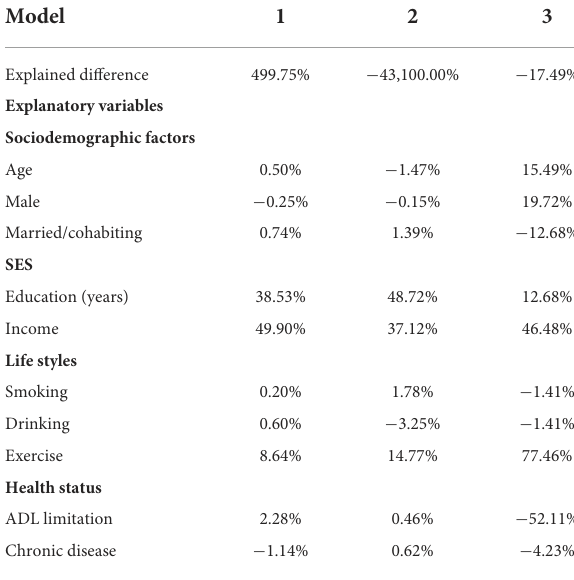
TABLE 7 Contribution of individual characteristics to the explained gap in depressive symptoms